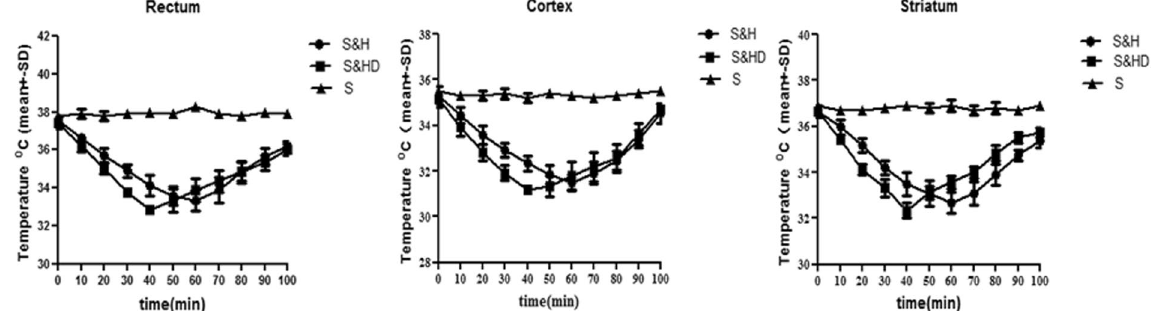
Figure 1. Reduction in temperature with C + P and/or mild hypothermia in the ( a ) rectum, ( b ) cortex and ( c ) striatum was measured in a time-dependent manner. As compared to stroke without treatment (S), ANOVA analyses indicated that combination therapy of C + P and mild hypothermia (S&HD) (squares) significantly induced a reduction in temperature to its maximum within 40 min and lasting up to another hour after reperfusion, whereas it took 20 min longer to get its maximum reduction in temperature by mild hypothemia alone (S&H) (circles) ( ** P <